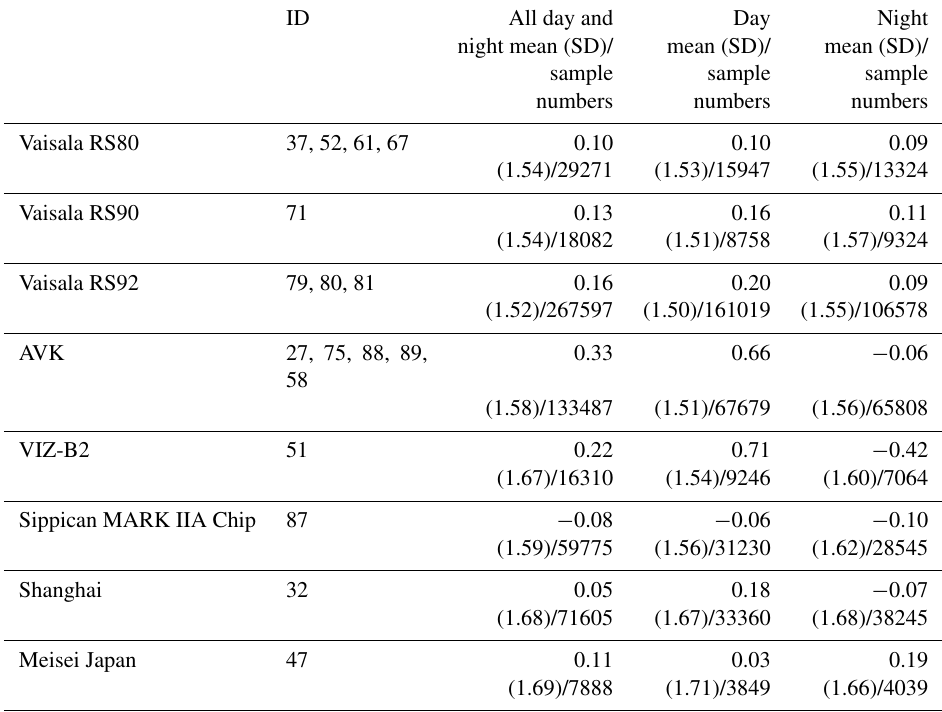
Table 2. Mean and standard deviation (SD) of temperature differences (K) from the layer from 200 to 20hPa between eight types of radiosonde a,b and